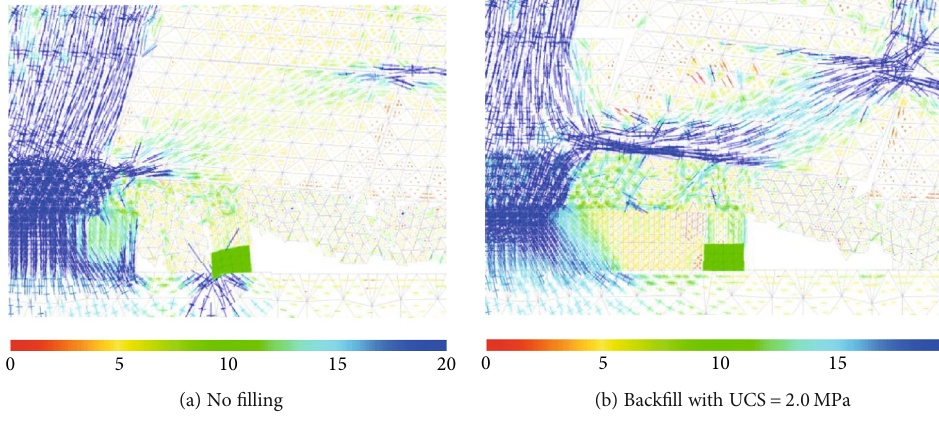
Figure 13: Stress tensor of the surrounding rock.